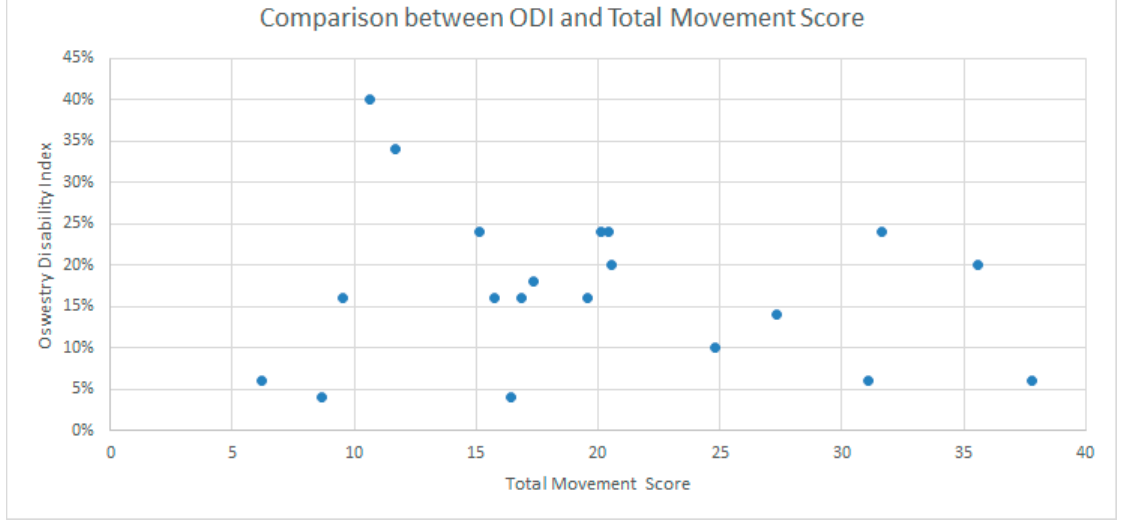
Figure 3. The plot of the values of disability (ODI%) and the total movement score